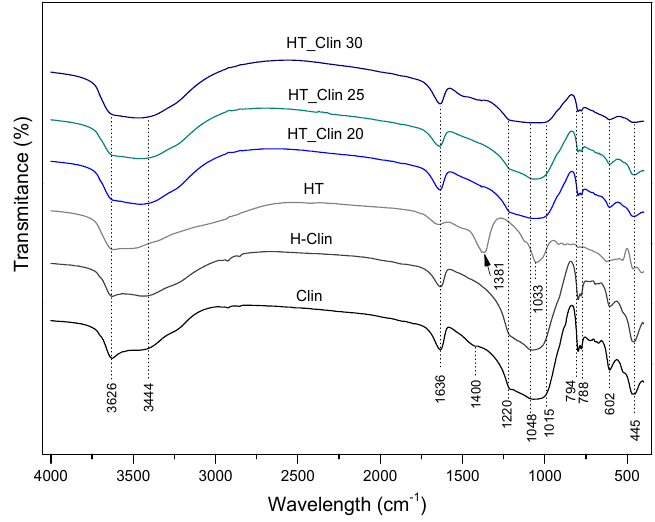
Figure 7. FT-IR spectra recorded for the investigated samples.